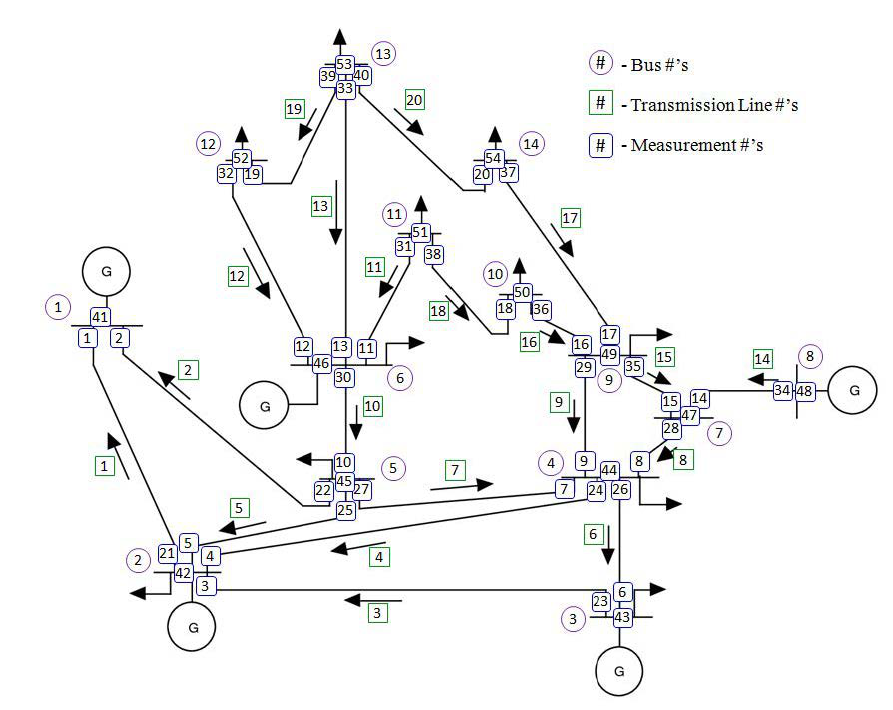
Figure 10. Standard IEEE 14 bus system